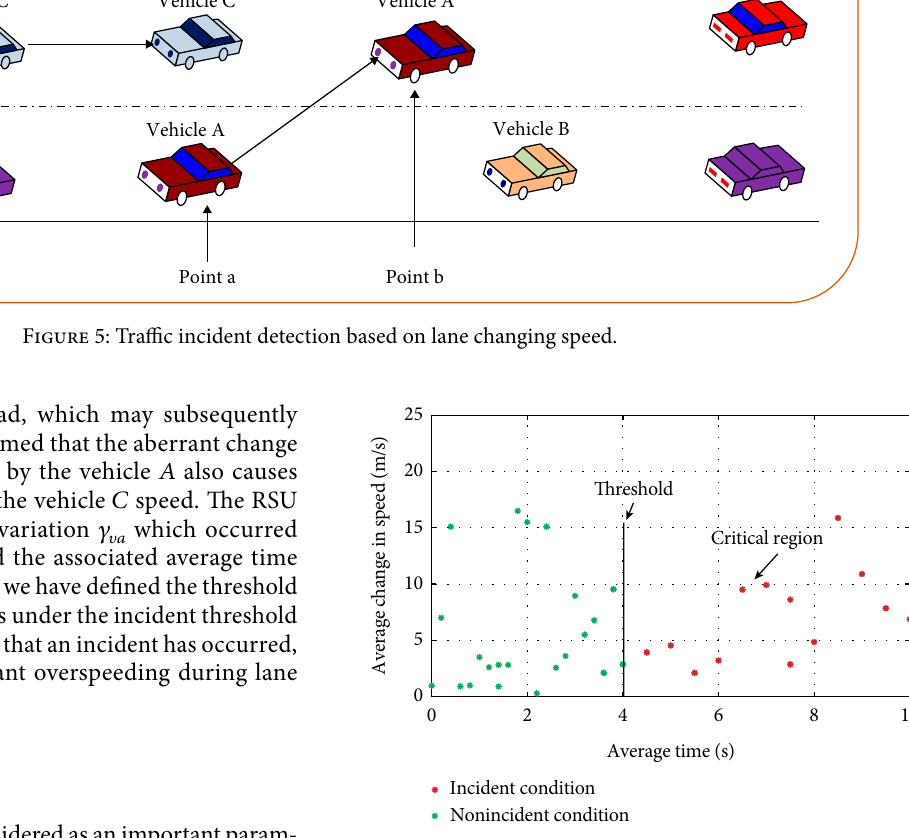
Figure 6: Incident detection threshold region for changing lane